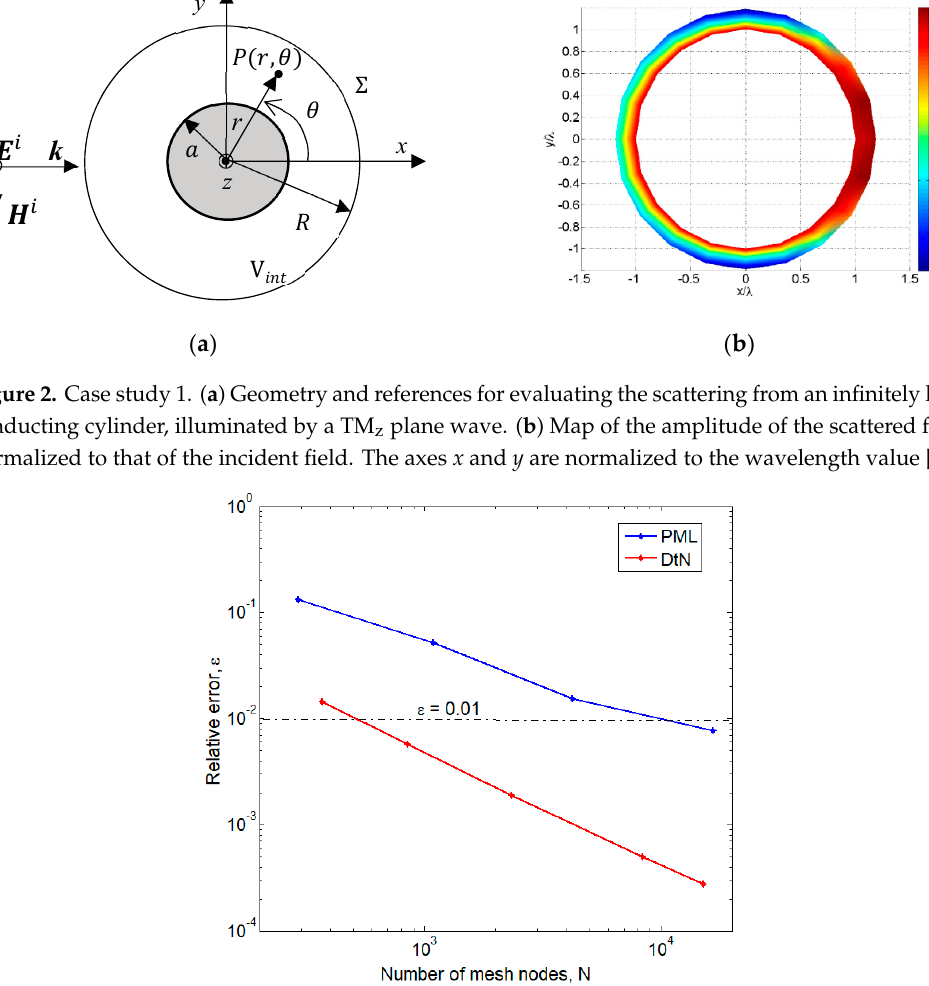
Figure 3. Case study 1 (perfectly conducting cylinder). Relative error as a function of the number of mesh nodes, for the DtN and perfect matching layer (PML) approaches. The PML solution refers to the optimized value of the layer thickness, δ = 1.4 λ .